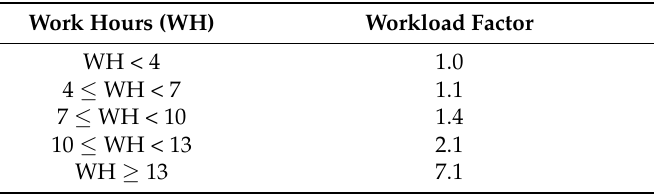
Table 7. Workload factor.